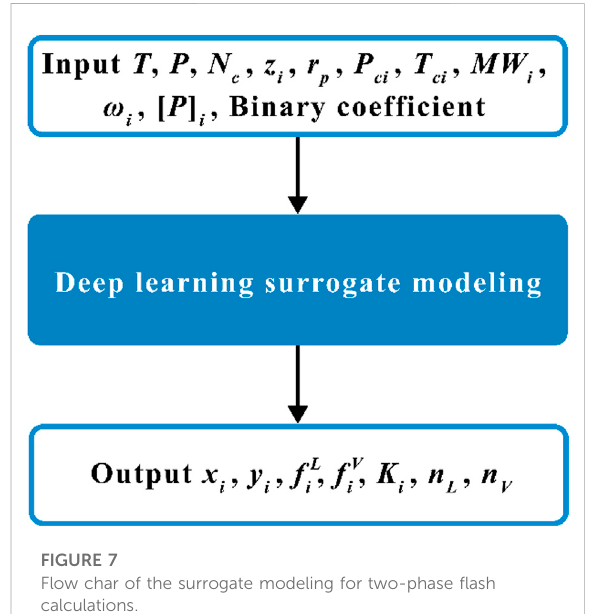
FIGURE 7 Flow char of the surrogate modeling for two-phase fl ash calculations.